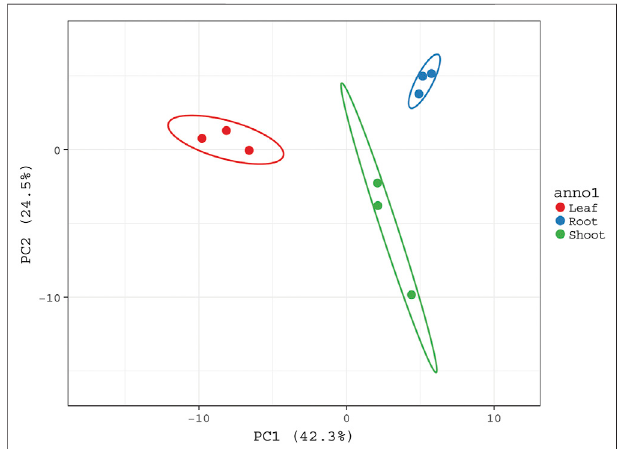
FIGURE 4 | PCA score plot sowing the variability of metabolic pro fi les of aerial rats and roots of G. uralensis . PCA plot was constructed based on abundance of different metabolites present in aerial and roots of G. uralensis . Allthreegroupscorrespondingtodifferentplantparts arewellseparated from each other based on the variability of their metabolic pro fi